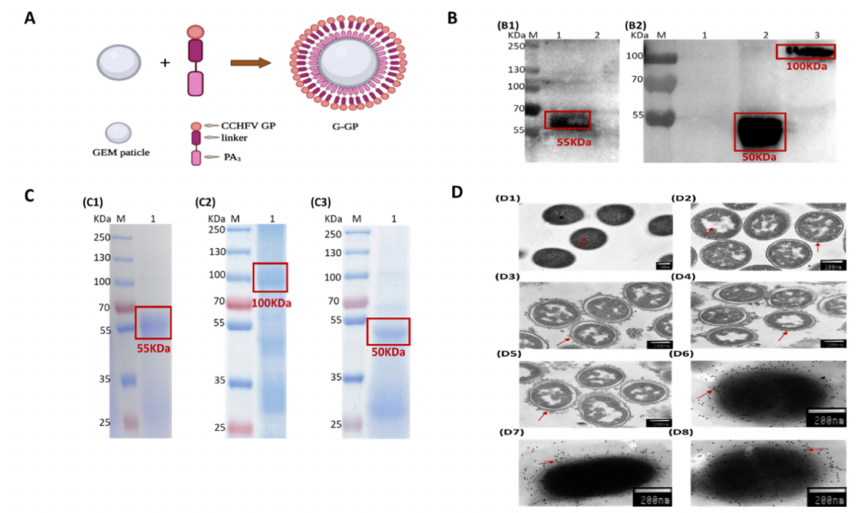
Figure 2. ( A ) Schematic representation of GP-PA binding with GEM particles. The CCHFV GP fragment of interest was fused at its C terminus with three LysM motifs (PA 3 ). The PA bound noncovalently to the peptidoglycan to formulate G-GP antigen. ( B ) Western blot analysis of the proteins displayed on GEM particles. Lane B1–1, Lane B2–2, Lane B2–3: eG N LP 3 , NAbLP 3 , eG C LP 3 proteins on GEM particles, proteins were detected with a mouse anti-CCHFV-G N polyclonal antibody or a mouse anti-CCHFV-pre-Gc monoclonal antibody (11E7); Lane B1-2, Lane B2-1: the mock control. ( C ) Detection of the fusion proteins displaying the GEM particles. C1-C3: SDS-PAGE analysis of the displaying of eG N LP 3 , eG C LP 3 and NAbLP 3 proteins on GEM particles. Lane C-1, C-3: GEM particles displaying eG N LP 3 / NAbLP 3 from the culture supernatant of rBV-eG N LP 3 -infected Sf9 cells; Lane C-2: GEM particles displaying eG C LP 3 from the supernatant after ultrasonic crushing of rBV-eG C LP 3 -infected Sf9 cells; ( D ) GEM particles identified by thin sectioning and immunoelectron microscopy of bacterium-like particles. D1: Untreated MG1363; D2: GEM particles; D3–D5: (G-eG N , G-eG C , G-NAb) particles; D6–D8: Immunoelectron microscopy of (G-eG N , G-eG C , G-NAb)